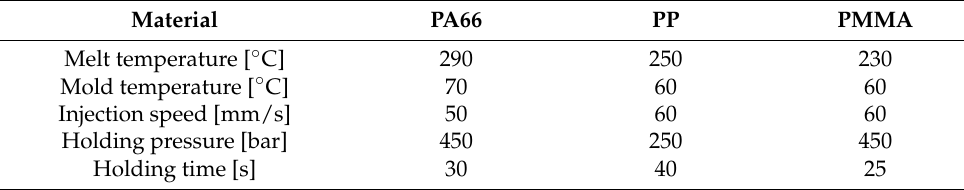
Table 1. Main injection ‐ molding parameters.